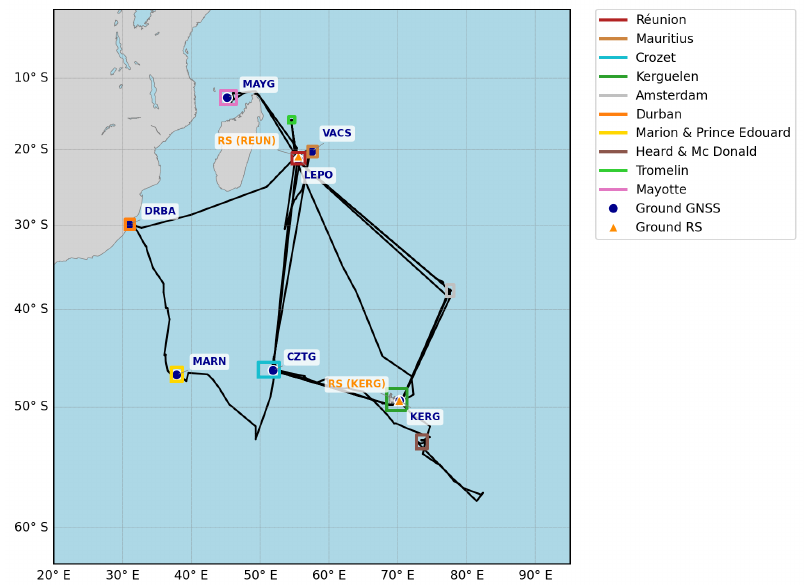
Figure 1. R/V Marion Dufresne tracks from 1 October 2020 to 30 June 2021 (black line); blue circles denote ground GNSS reference stations; orange triangles denote ground-based radiosounding stations; coloured bold lines correspond to the different geographical zones that are crossed during the period.